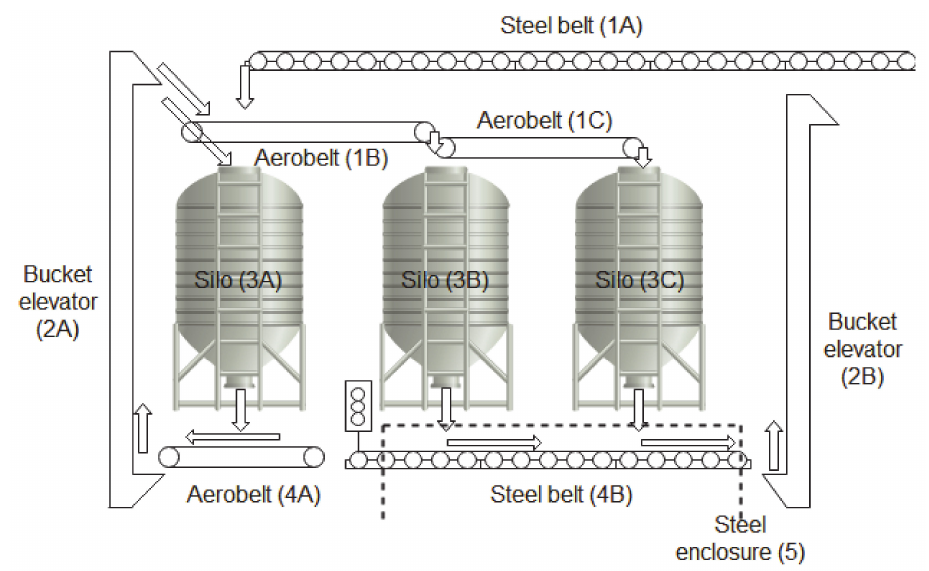
Figure 2. Granulated sugar supply and discharge through the silos. Arrows indicate where sugar flows. In brackets, the dedicated node is